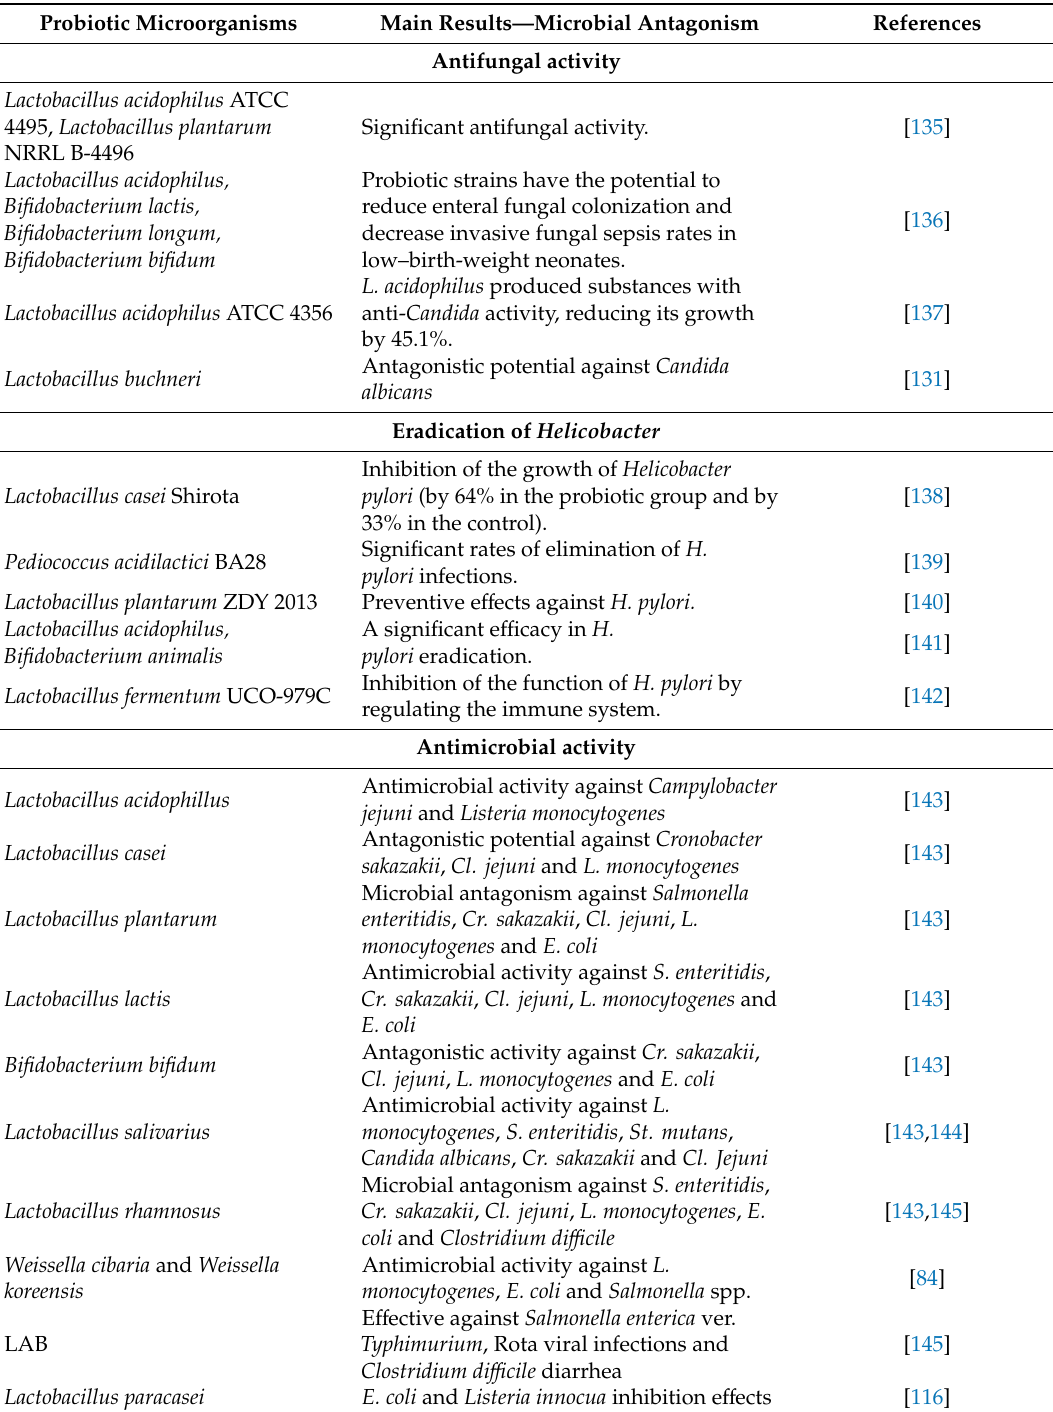
Table 4. Clinical studies and reported specific benefits to human health—Microbial